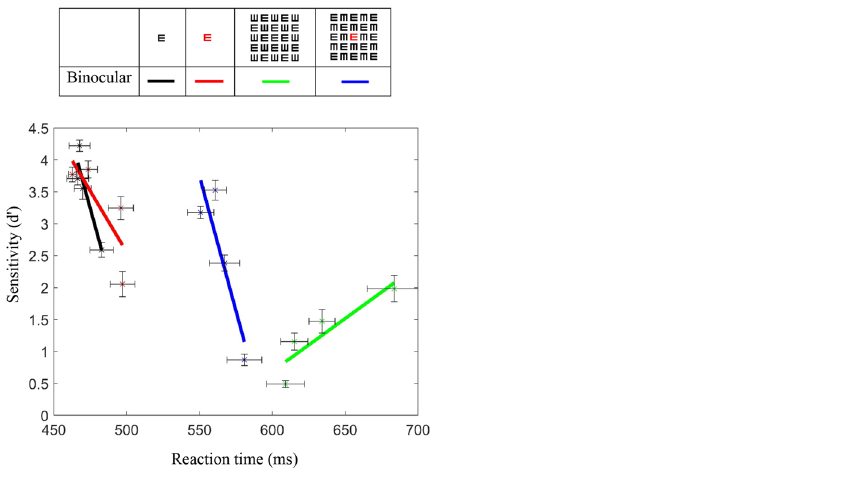
Figure 4. Perceptual load limited capacity: Sensitivity under binocular conditions. The sensitivity trade-off for RT; the processing of letter recognition under crowded conditions (the black letter) requires more processing efforts (the green continuous line). RT SE is represented by the horizontal error bar. d ′ s SE is represented by the vertical error bar. Error bars represent ± SE of the